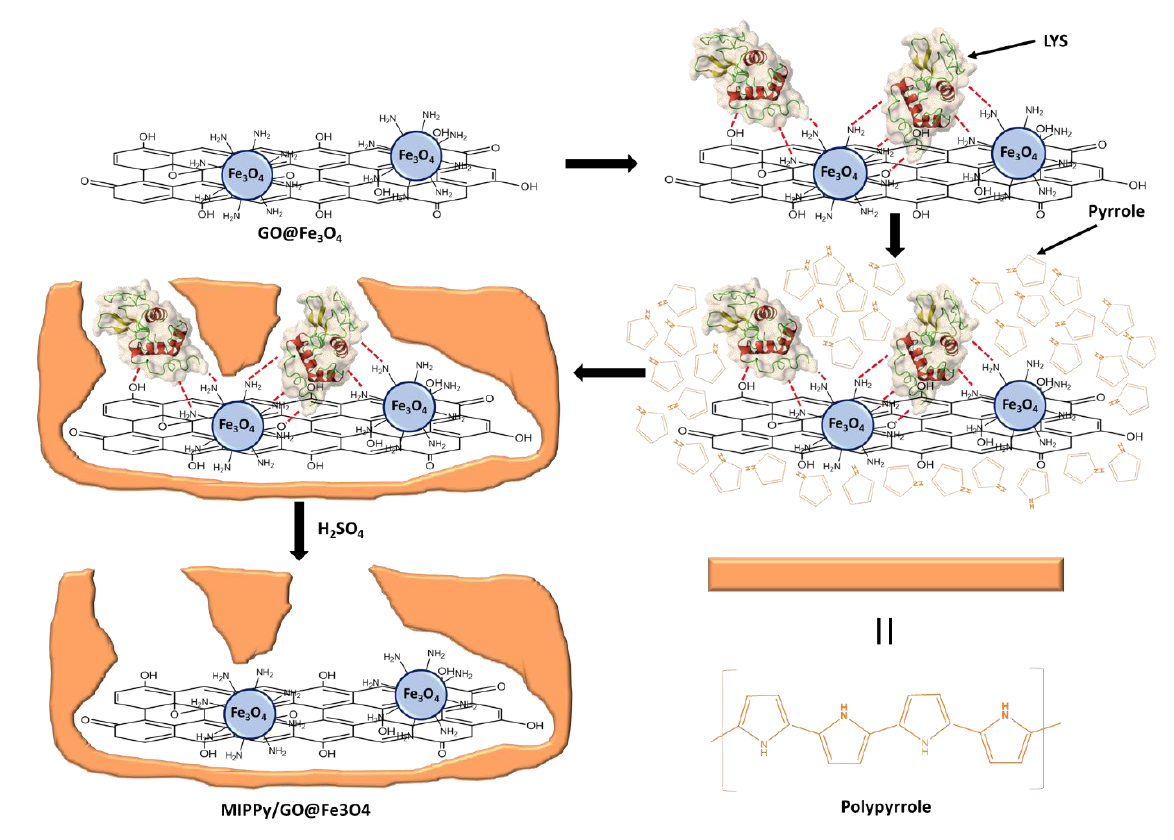
Figure 1. Synthesis process of MIPPy/GO@Fe 3 O 4 .